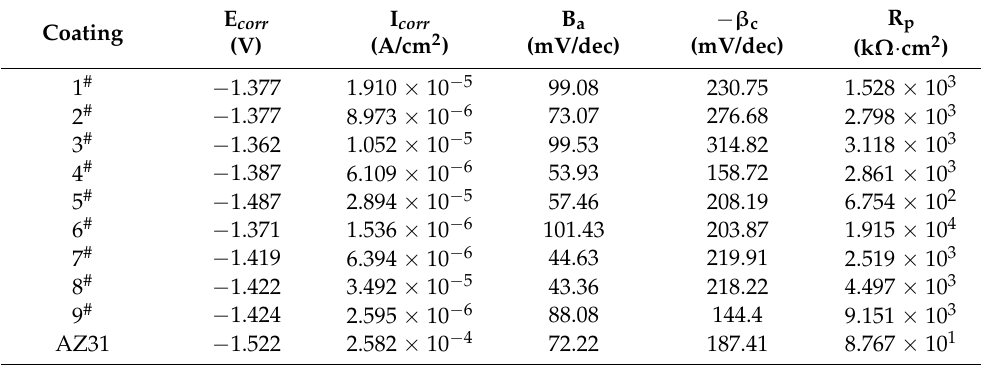
Figure 9. Potentiodynamic polarization curves of AZ31B magnesium alloy and black MAO coating samples 1 # –9 # . Table 4. Parameter values of potentiodynamic polarization curves of AZ31B magnesium alloy and black MAO coating samples 1 # –9 # in 3.5 wt.% NaCl solution.